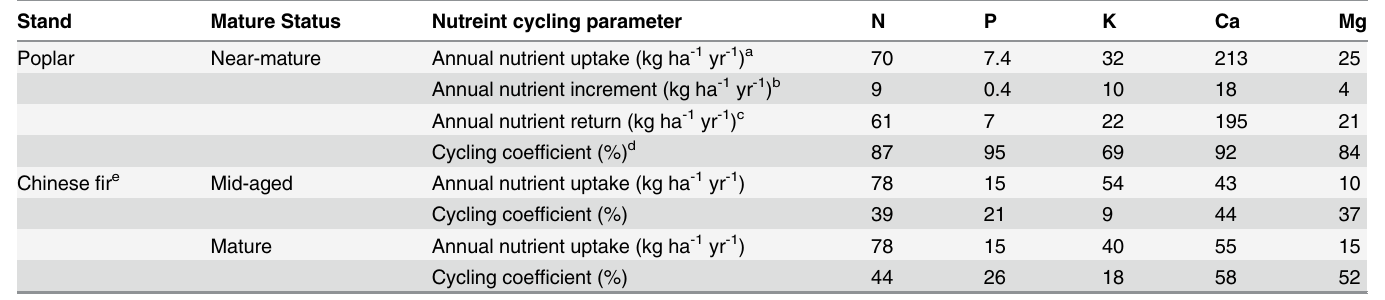
Table 4. Nutrient cycling of aboveground poplar and Chinese fir at different maturity stages. Stand